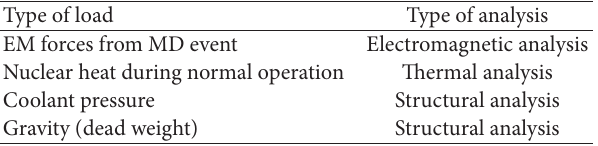
Table 4: Results of sensitivity